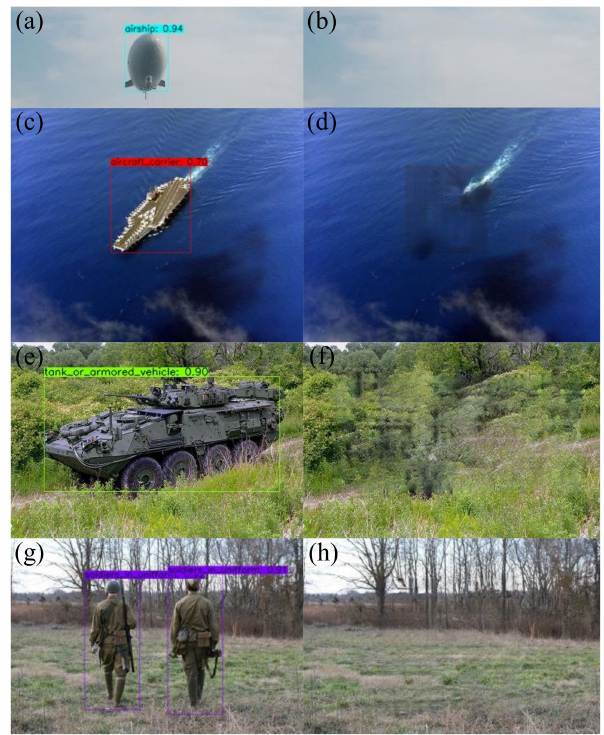
Figure 10. More detailed experimental results. ( a ) airship; ( b ) preliminary camouflage texture of the airship; ( c ) aircraft carrier; ( d ) preliminary camouflage texture of the aircraft carrier; ( e ) tank; ( f ) preliminary camouflage texture of the tank; ( g ) uniformed soldiers; ( h ) preliminary camouflage texture of the uniformed soldiers.